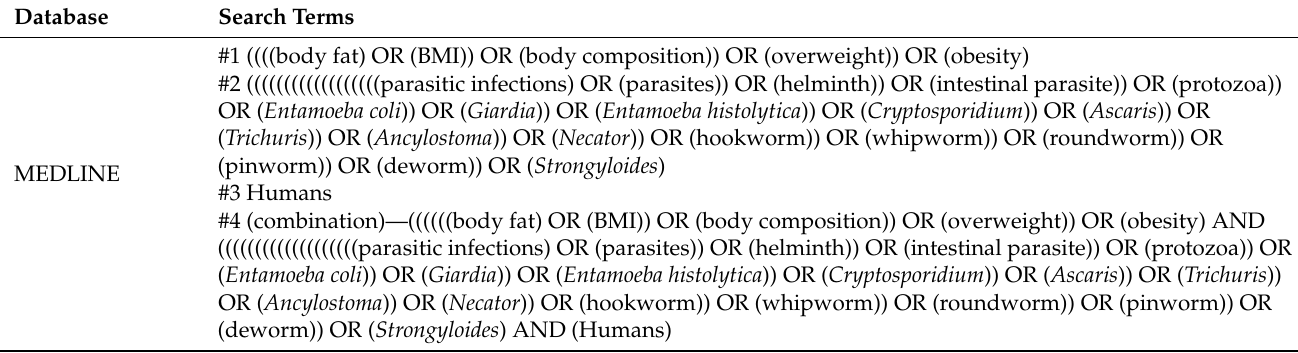
Table 1. Search strategies used in the